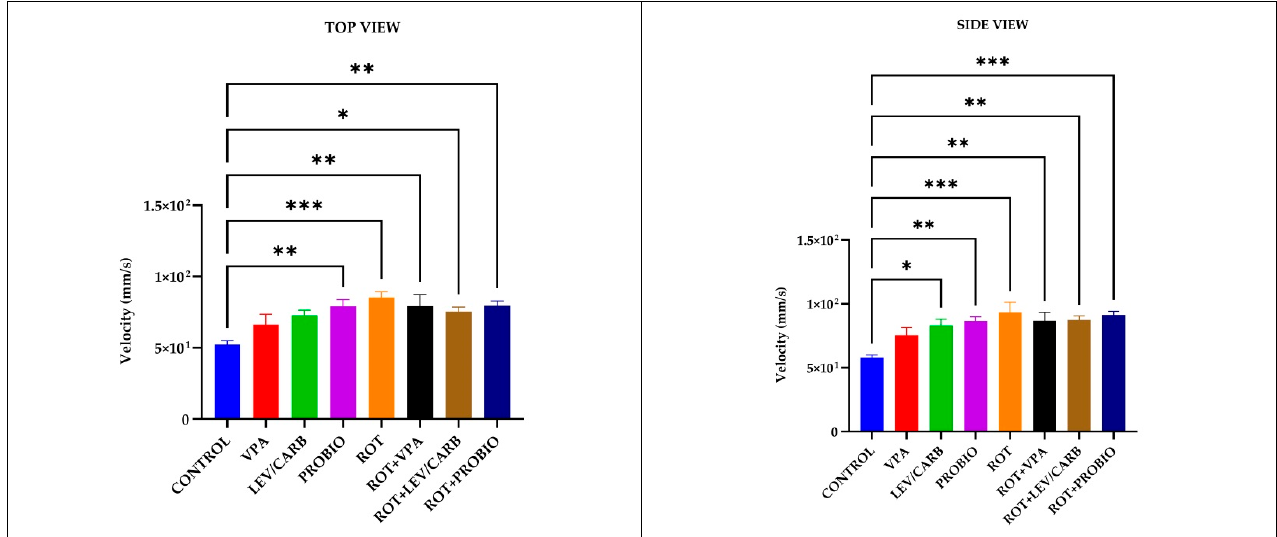
Figure 3. Velocity (mm/s) patterns in studied Danio rerio ( n = 5) groups (*— p < 0.05; **— p < 0.005;